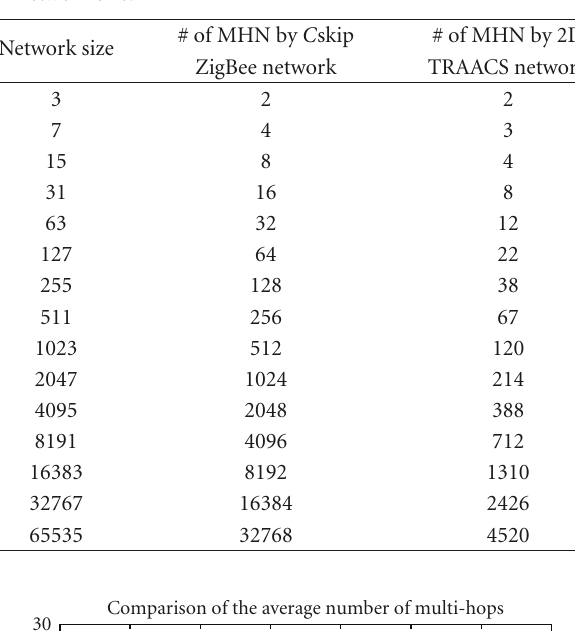
Table 2: The numbers of MHN of di ff erent topologies as a function of network size.